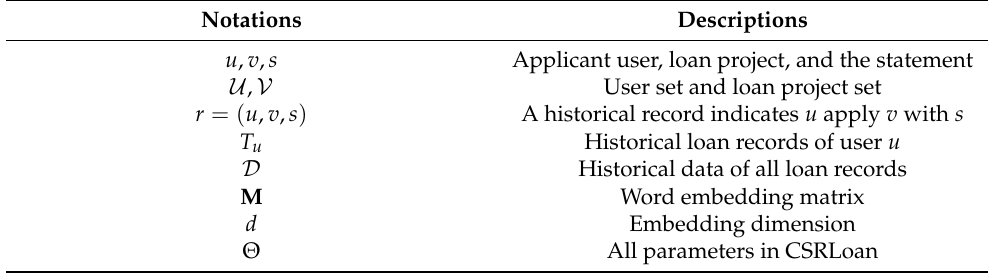
Table 1. Notations used in this